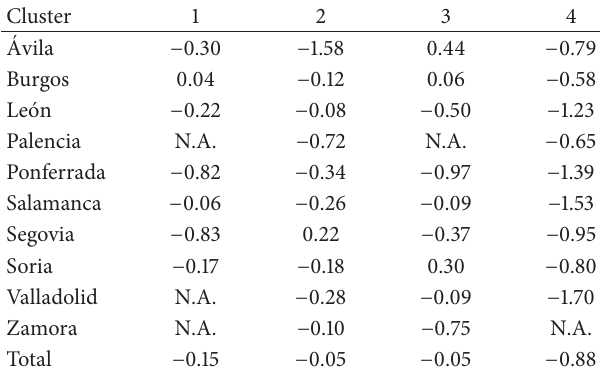
Table 1: Average NAO index on heavy snow events, by cluster and